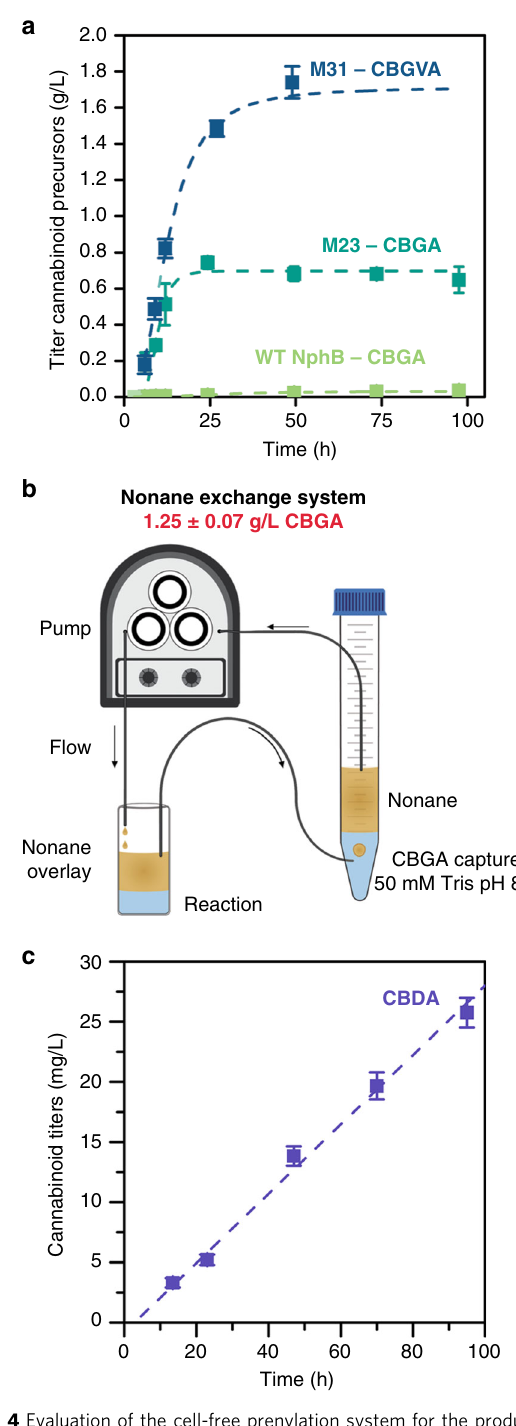
Fig. 4 Evaluation of the cell-free prenylation system for the production of various cannabinoids. a The cell-free enzymatic production (from glucose) of cannabinoid precursors over time. CBGA production using M23 is shown in the dark aqua trace and WT NphB in the light green trace. The production of CBGVA using M31 is shown in the dark blue trace. The concentration of WT, M23, and M31 NphB was fi xed at 0.5 mg/mL (biological replicates, n = 3). b Using a nonane- fl ow CBGA capture system, we were able to obtain a higher titer of CBGA (1.2 g/L). The nonane layer was exchanged using a peristaltic pump, which circulated the nonane in the direction indicated by the arrows. c Production of CBDA over time using CBDAS (biological replicates, n = 3). All error ranges are the standard deviation. Source data for Fig. 4a, c are provided as a Source Data fi